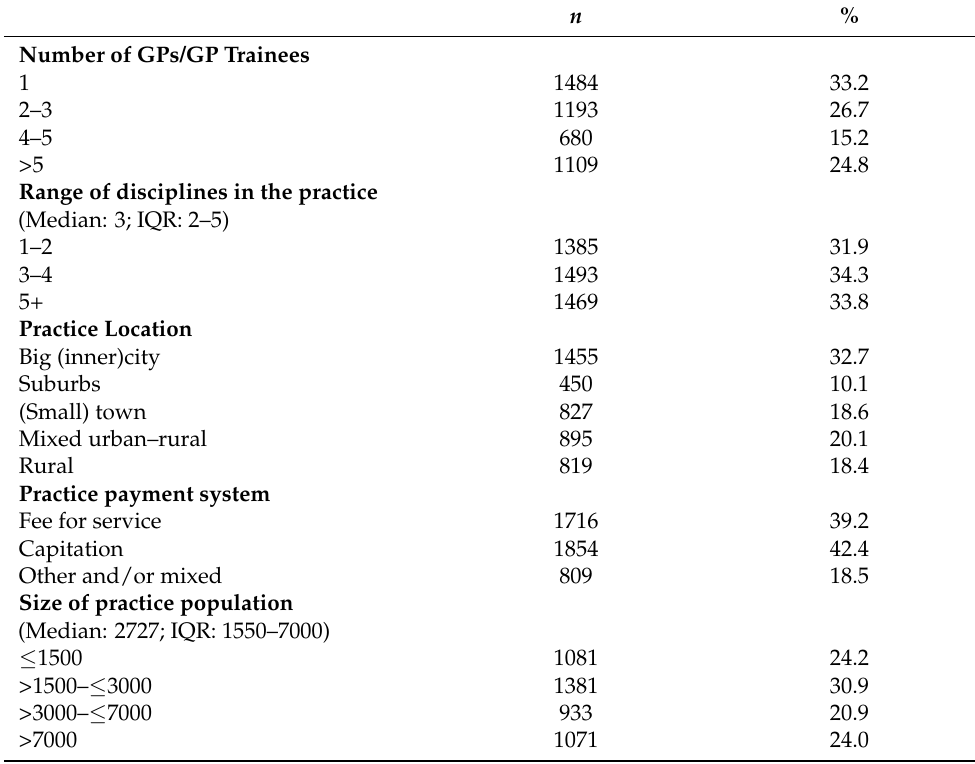
Table 2. Practice